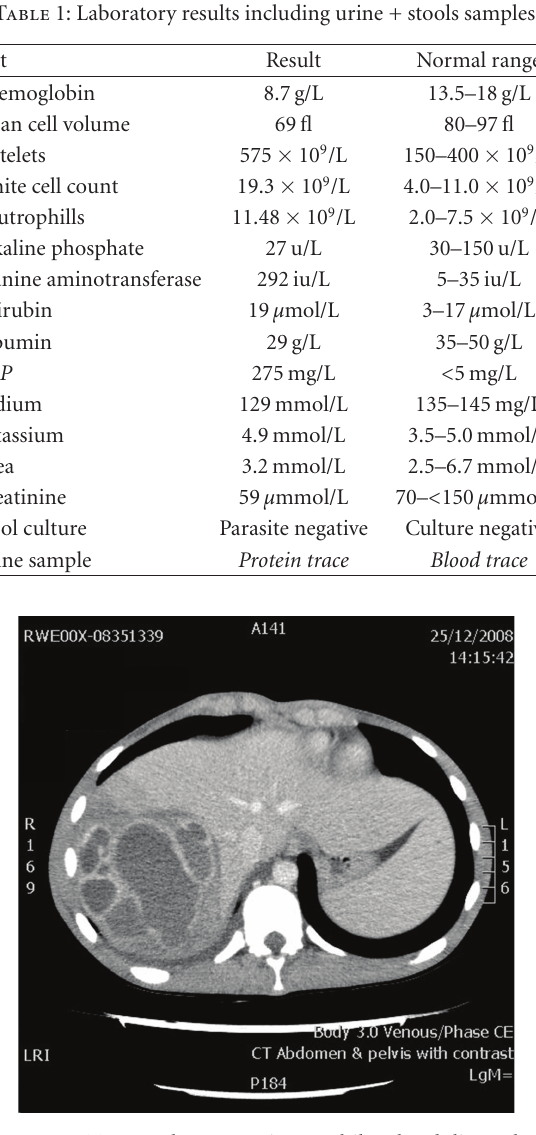
Figure 1: CT scan demonstrating multiloculated liver abscess containing at least 10 locules.